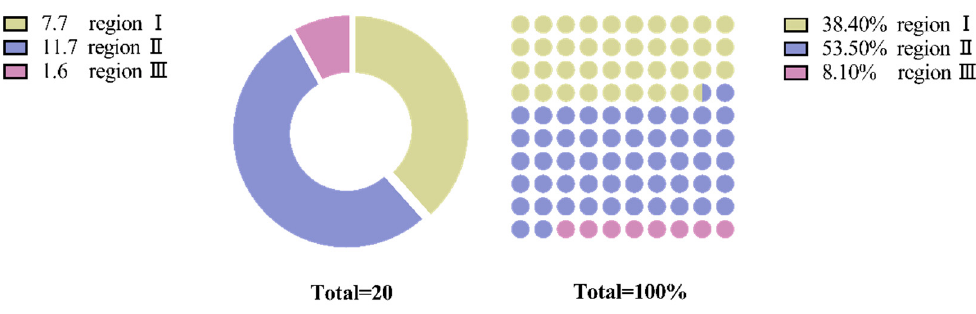
Figure 10. Statistics of the location of the pitting damage.